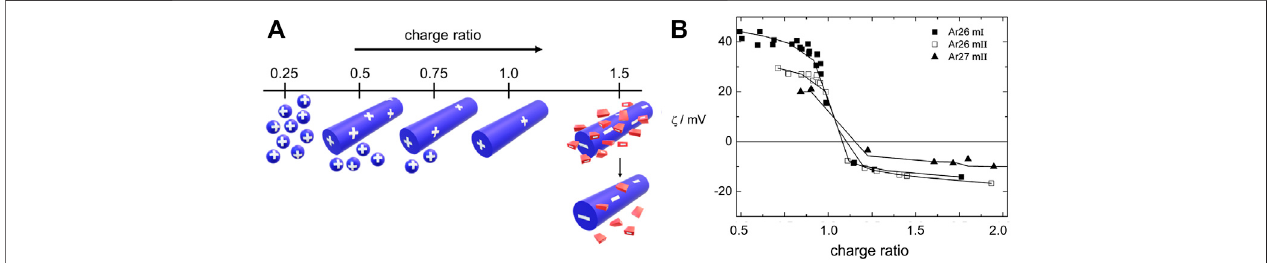
FIGURE10| Chargeratio-dependentassembly-formationinacationicdendrimer-anionicdyesystem: (A) Scheme:smallspheresrepresentindividualdendrimers, cylinders larger assemblies, and red rectangles dye molecules. Bound dye molecules are not sketched for simplicity; “ + ” and “ − ” represent the sign and relative magnitude of the net charge; (B) ζ -potential in dependence on charge ratio (Willerich et al., 2010). Reprinted with permission. Copyright © 2010 American Chemical Society.